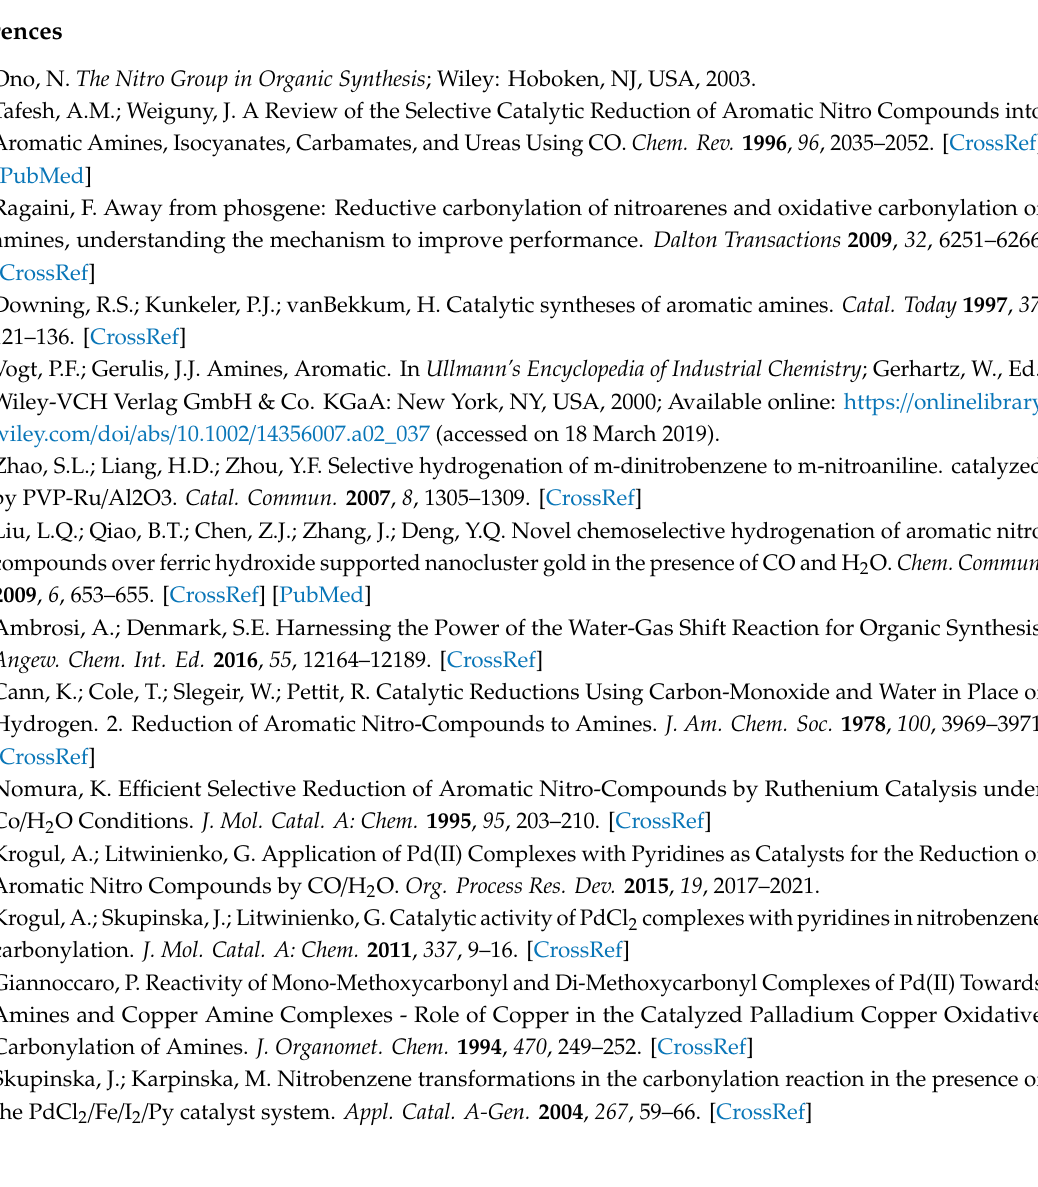
Figure S6. TG curves for centrifuged and dried PdNPs stabilized by 4MePy, DMAP, and 4EtPy; Figure S7. XPS Pd 3d spectra of: A) nanoparticles from raw solution, B) NPs centrifuged and suspended in ultrapure water, C) NPs dried and re-suspended in ultrapure